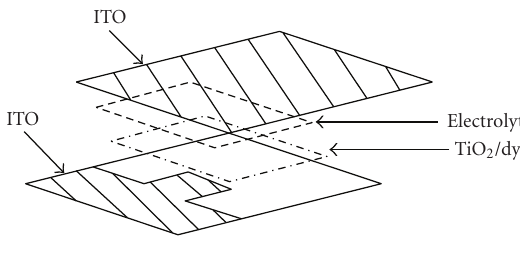
Figure 1: Diagram of PEC cell.